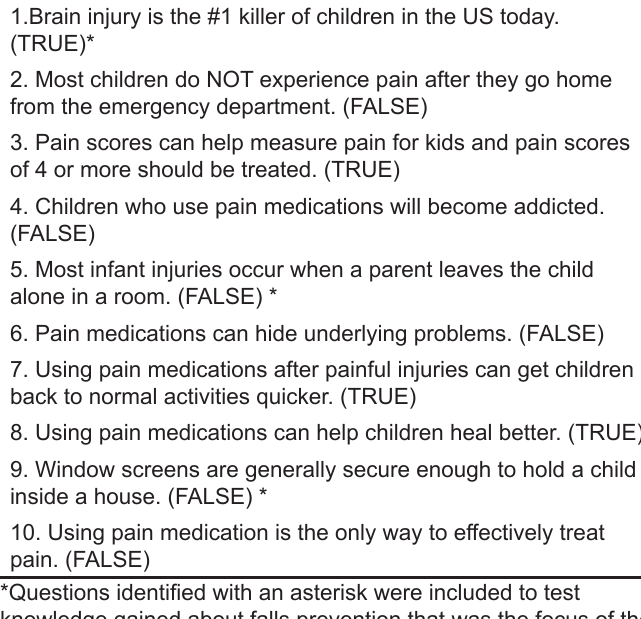
Table 1. Pain knowledge